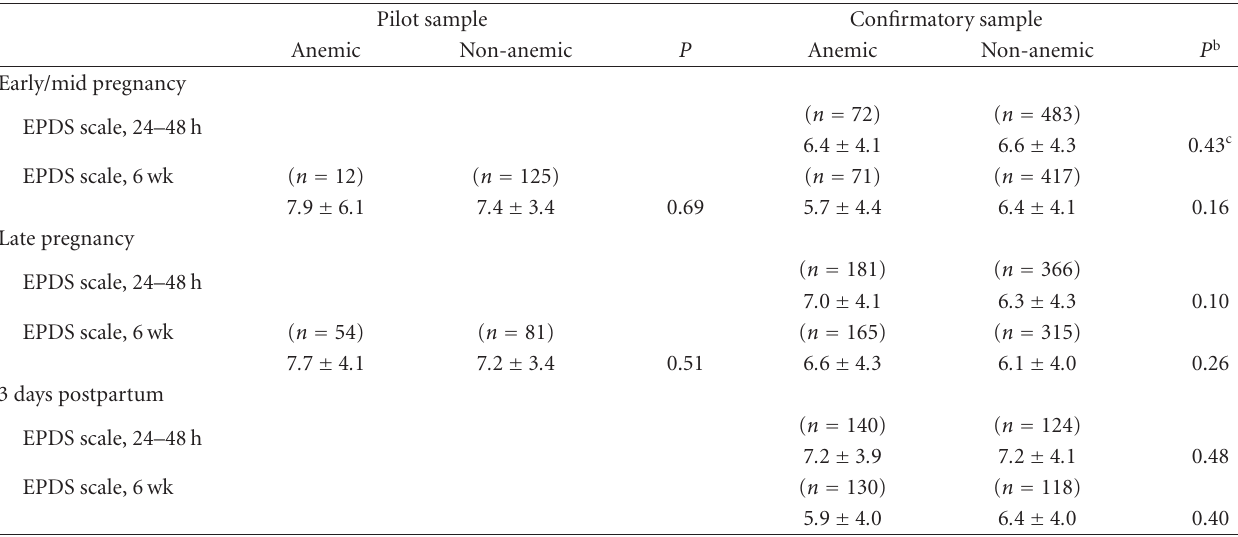
Table 4: EPDS total scores in anemic and nonanemic mothers a